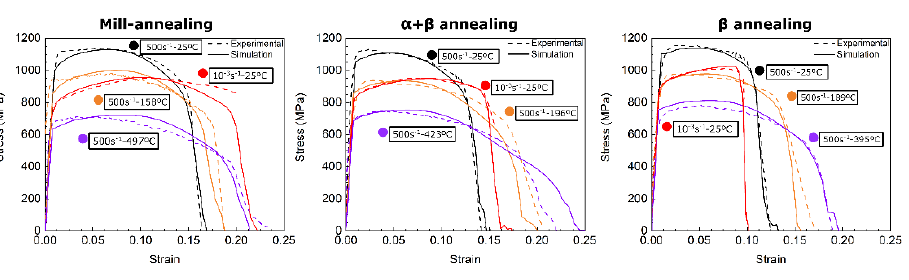
Figure 7 : Comparaison between experimental tests and FE simulation as a function of the temperature, strain rate and